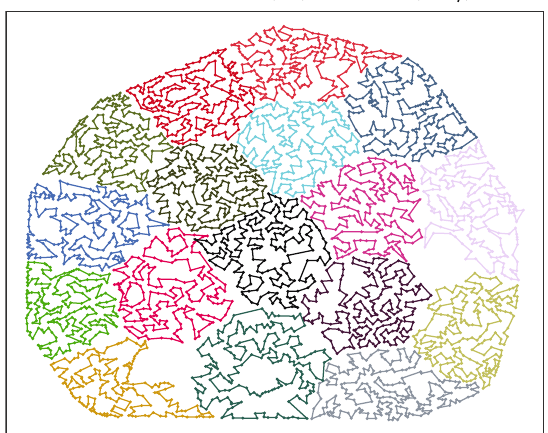
Figure 6: The speci fi c disinfection routes in the case